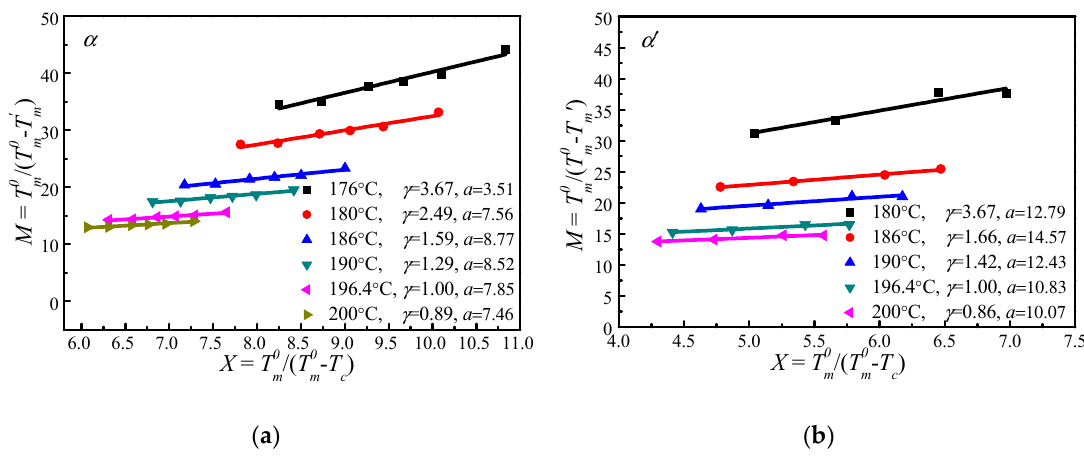
Figure 6. Plots of the scaled observed melting temperature (cid:1846) (cid:2923)(cid:2868) /(cid:4666)(cid:1846) (cid:2923)(cid:2868) − (cid:1846) (cid:2923)(cid:4593) (cid:4667) vs. the scaled crystallization temperature (cid:1846) (cid:2923)(cid:2868) /(cid:4666)(cid:1846) (cid:2923)(cid:2868) − (cid:1846) (cid:2913) (cid:4667) under different (cid:1846) (cid:2923)(cid:2868) , ( a ) α and ( b ) α′ crystal structure.